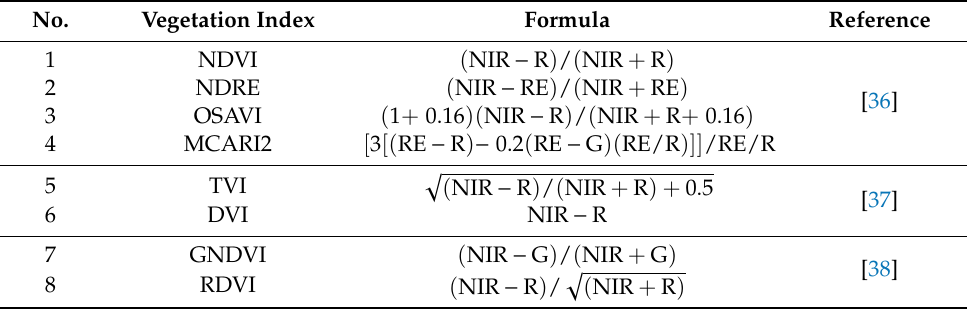
Table 1. Formulas and corresponding citation for vegetation